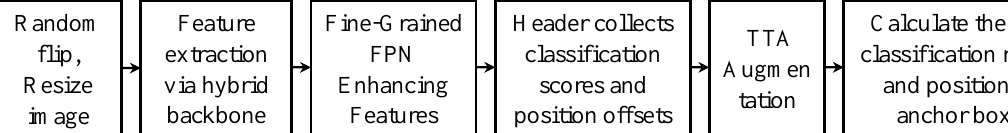
Figure 2. Overview schematic diagram of our algorithm. The images are fed into the network, first through a series of enhancements, then through a hybrid backbone network to extract features and a fine-grained pyramid to enhance the features. Finally, TTA is used to improve recognition